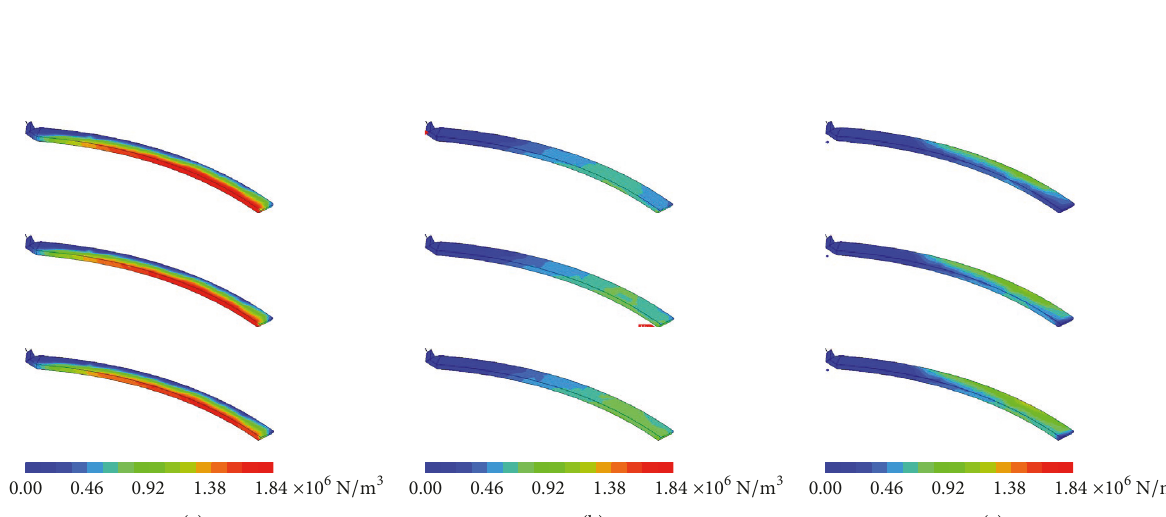
Figure 9: Definition of rotor relative length.